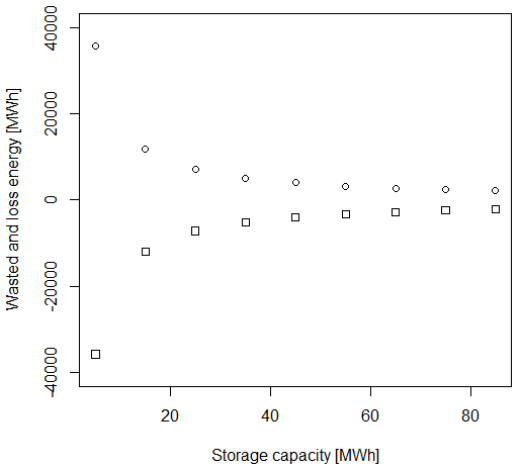
Figure 11. Evolution of waste (U) and loss energy ( − L) according to storage capacity.